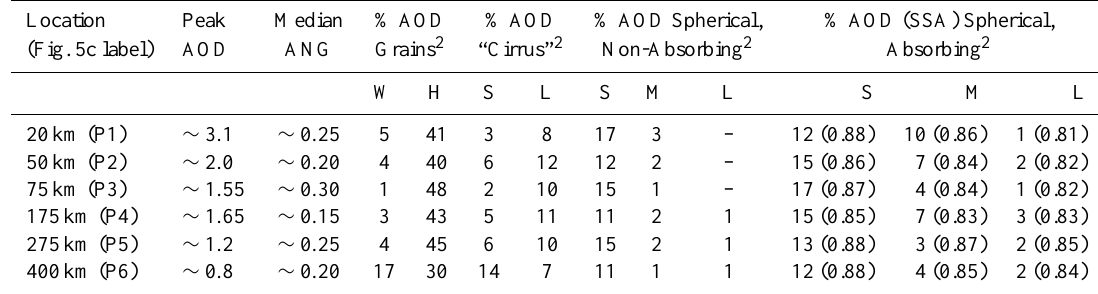
Table 4. Research Retrieval results overview for the 19 April 2010 plume. 1 See Fig. 5c for context. Location Peak Median % AOD % AOD (Fig. 5c label) AOD ANG Grains 2 “Cirrus”